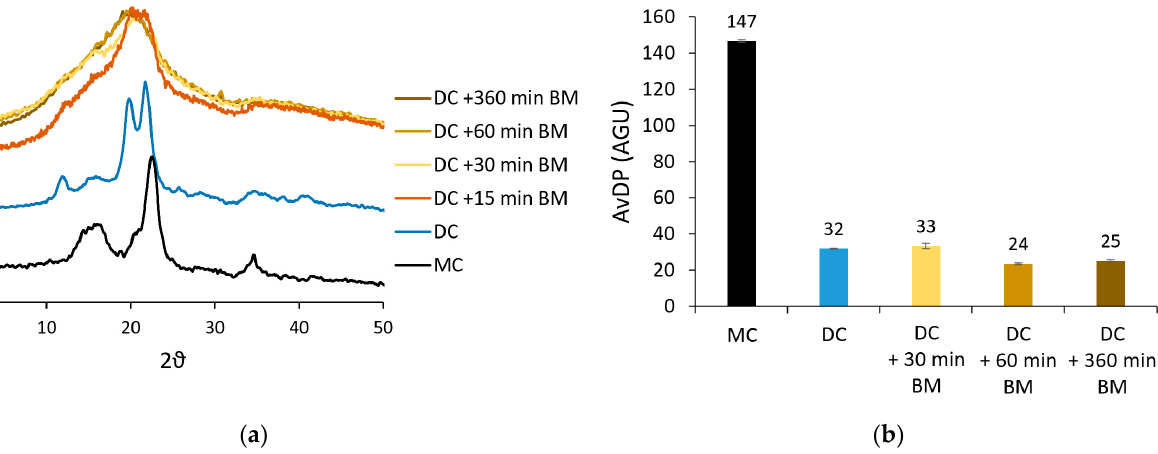
Figure 2. Effect of the ball mill (BM) treatment time (500 rpm) on the ( a ) crystallinity and ( b ) average degree of polymerization (avDP) of depolymerized cellulose (DC). Error bars represent the standard deviation of the analysis. The starting material, microcrystalline cellulose (MC), is included in both figures as a reference.